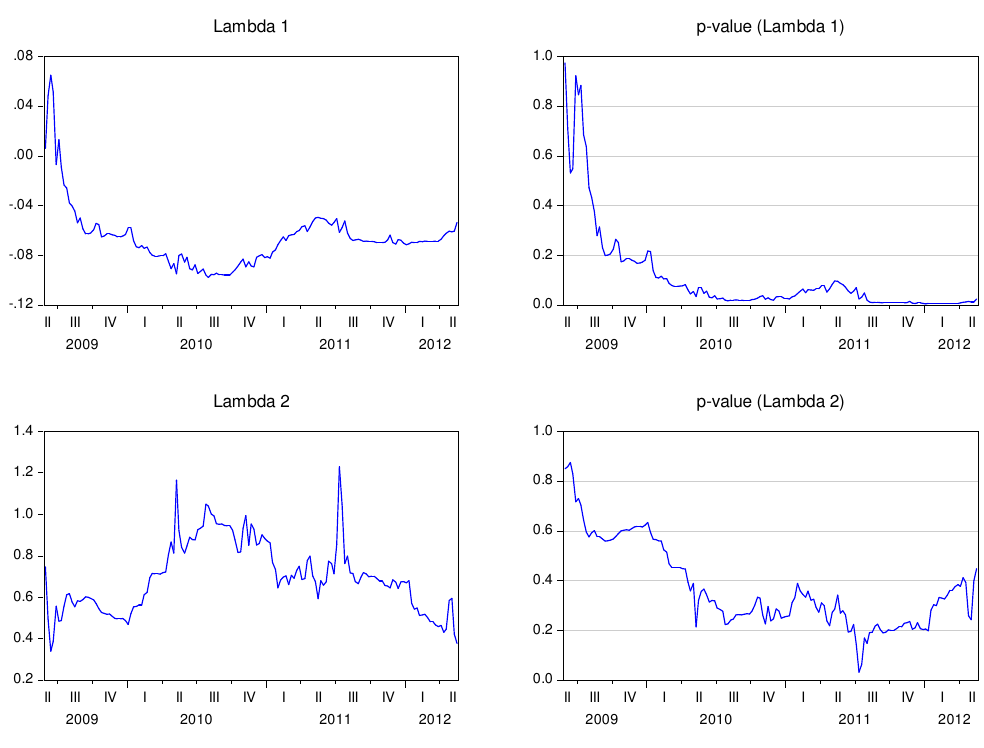
Figure 8. Recursive estimation of the speed adjustment parameters — Greece.